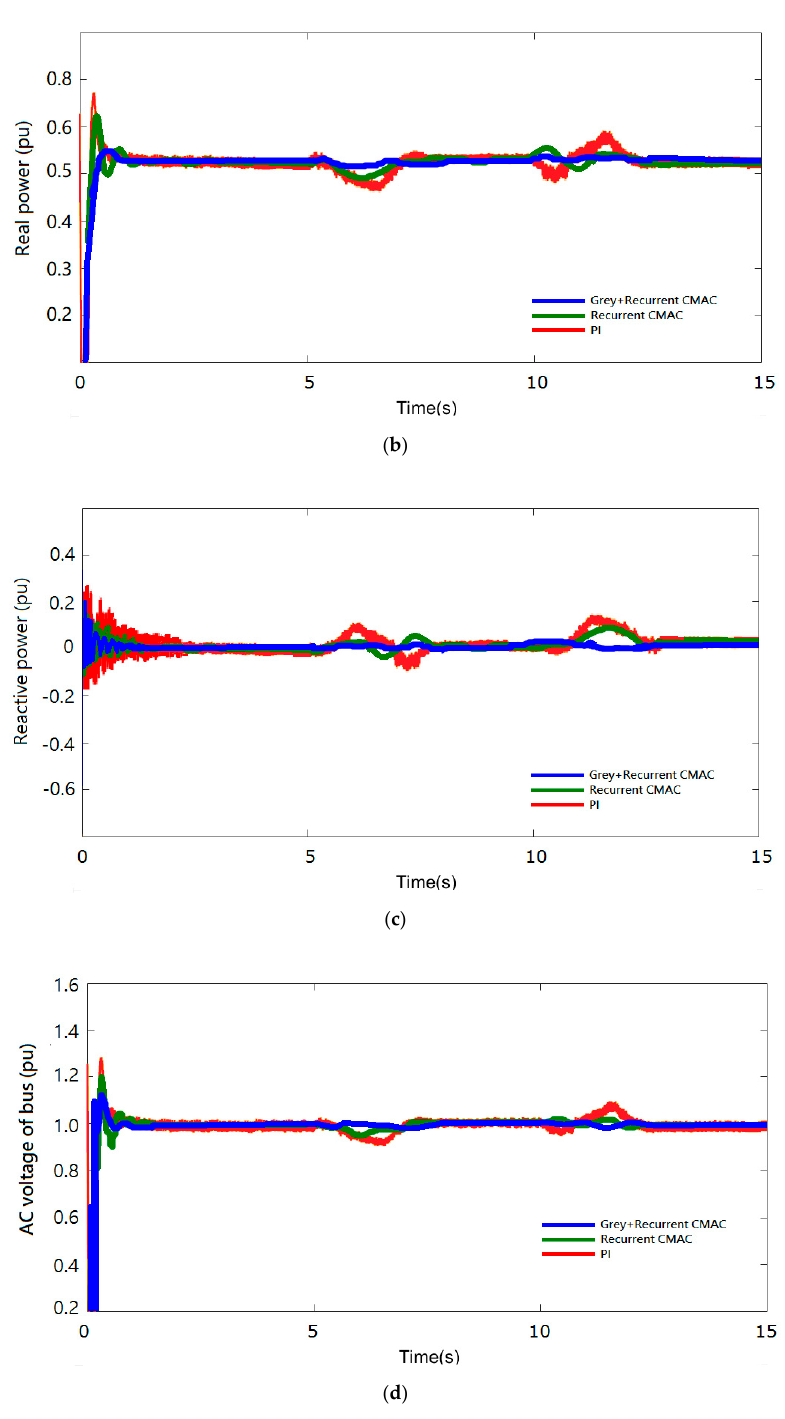
Figure 6. Dynamic responses of the studied system with load changes: ( a ) Wells turbine’s rotor speed response, ( b ) the real power response of WECS, ( c ) the reactive power response of WECS, and ( d ) dynamic voltage amplitude response of AC bus on power grid